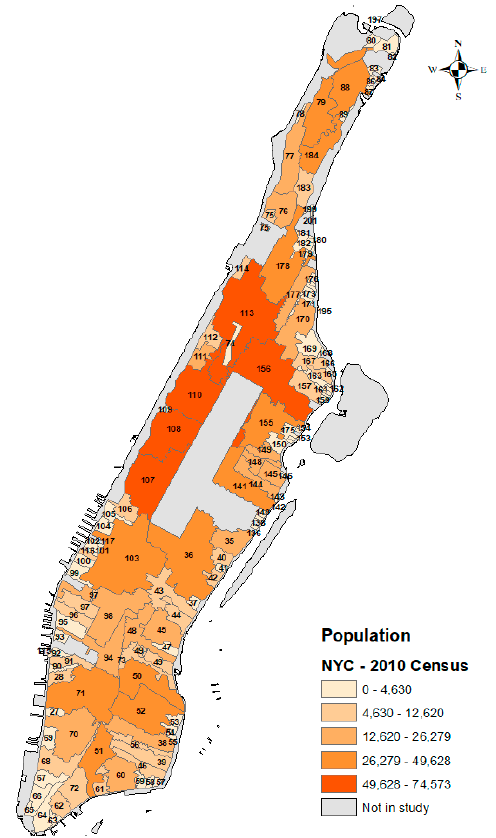
Figure 1. Area of study, Manhattan Island NYC—Sub-basins in the study labeled as numbers and corresponding population densities.